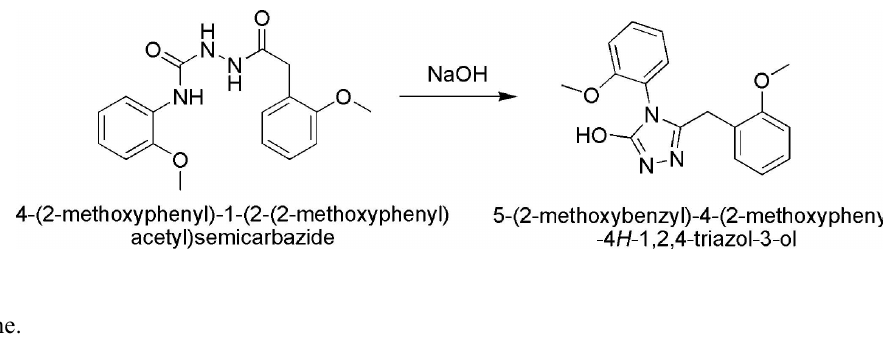
Figure 2 A partial packing diagram. Hydrogen bonds are shown as dashed lines.